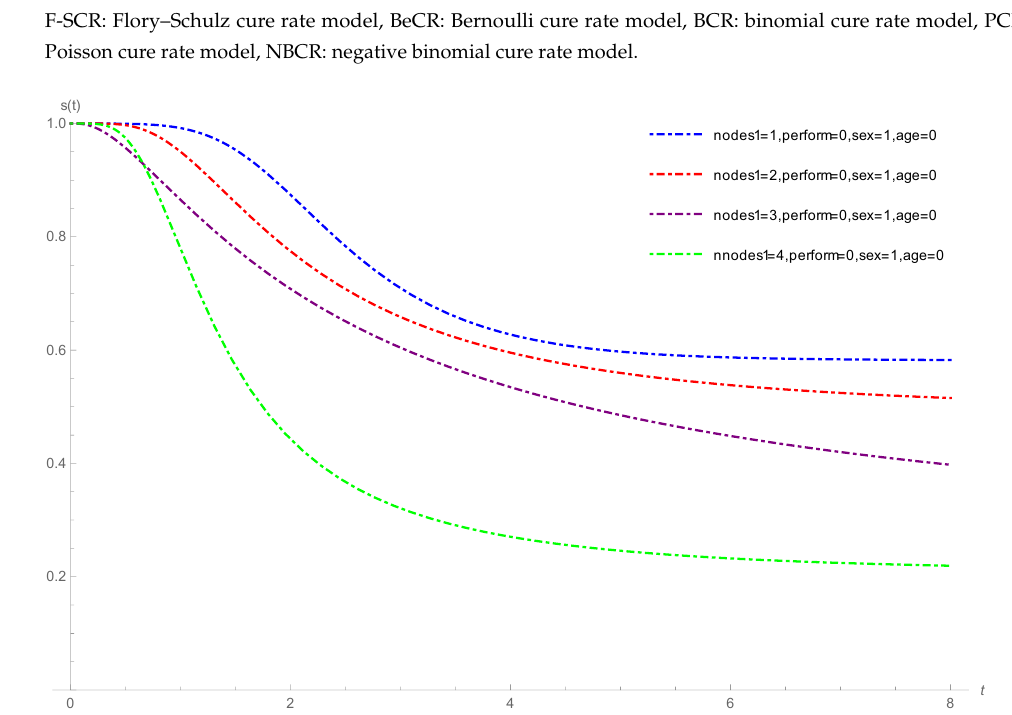
Figure 6. Plots of the survival functions for the melanoma data based on F-SCR/GeTNH model stratified by nodule category (1 to 4); perform: fully active; sex: female; age: below